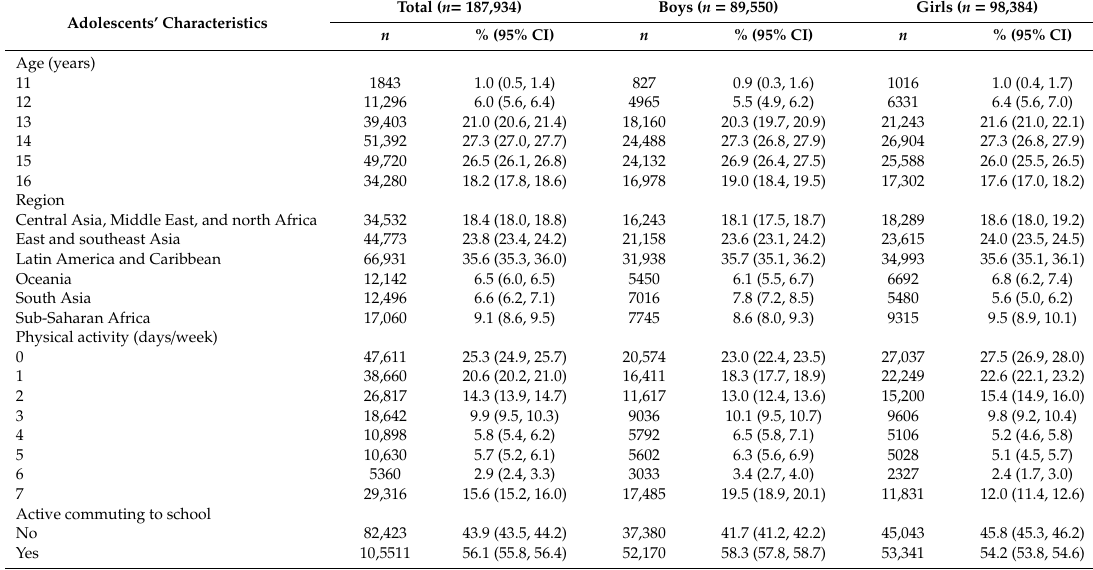
Table 1. Adolescents characteristics, including age, region, physical activity, and active commuting to school, by sex.